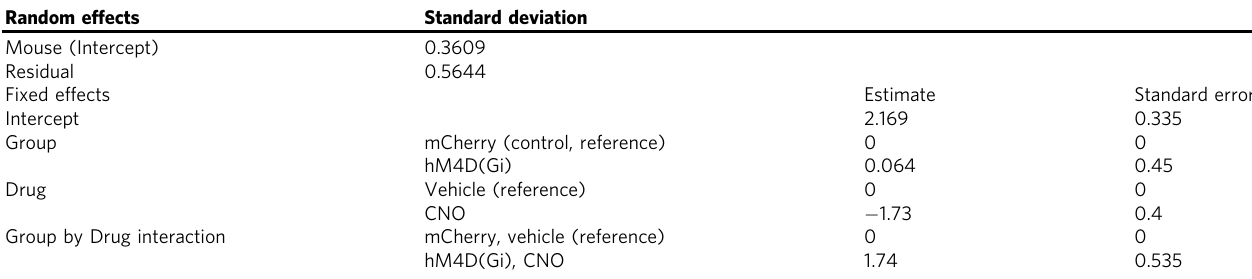
Table 3 LME model: the effect of chemogenetic inhibition of VM on REM sleep duration Random